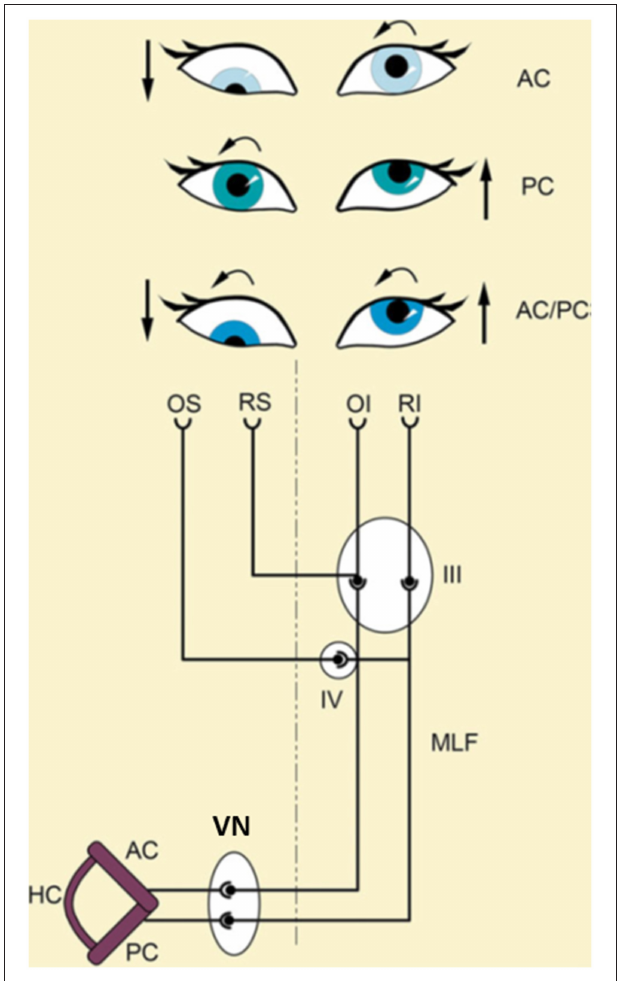
FIGURE 4 | Schematical explanation of different types of ocular tilt reaction (OTR) according to the input of the affected semicircular canals. The ascending-VOR type of OTR is characterized by monocular or dysconjugate skew torsion of the eyes depending on whether input from fibers of the posterior (PC), anterior (AC), or both semicircular canals (AC/PC) to the extraocular eye muscles are affected. An excitatory ascending pathway projects from the AC to the ipsilateral superior rectus (RS) and the contralateral inferior oblique (OI) muscle. A lesion of this pathway causes a hypotropia of the ipsilateral eye and an incyclotropia of the contralateral eye (AC type; top ). An excitatory ascending pathway is linked from the posterior semicircular canal to the ipsilateral superior oblique (OS) and the contralateral inferior rectus (RI) muscle. A lesion of this pathway causes excyclotropia of the ipsilateral eye and hypertropia of the contralateral eye (PC type; middle ). A combination of both canals (AC/PC) induces a complete OTR ( bottom ). III, oculomotor nucleus; IV, trochlear nucleus; VN, vestibular nucleus; MLF, medial longitudinal fascicle [Modified from Brandt and Dieterich (23) and Dieterich and Brandt (35)]. which—when damaged—cause either contralateral or